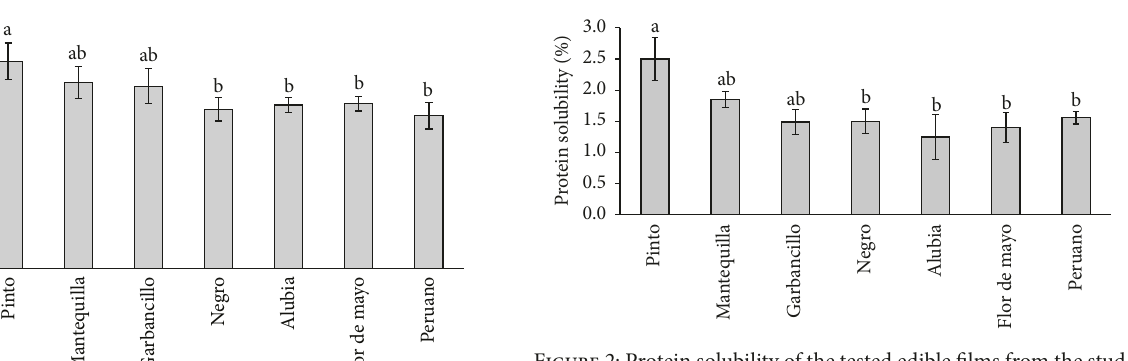
Figure 2: Protein solubility of the tested edible films from the stud- ied bean varieties. Means with the same letter are not significantly ( 𝑝 > 0.05 )